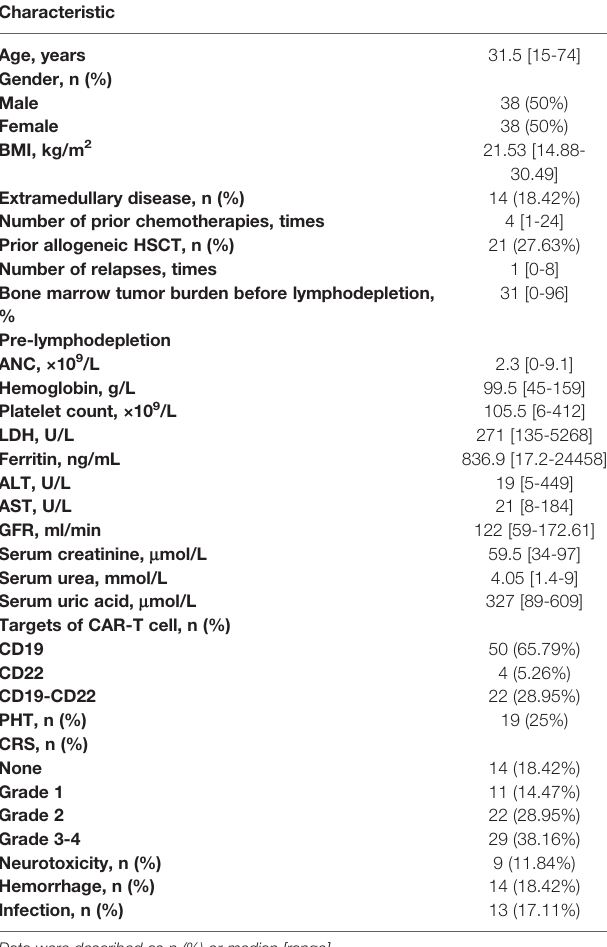
TABLE 1 | Demographic and clinical characteristics of ALL patients